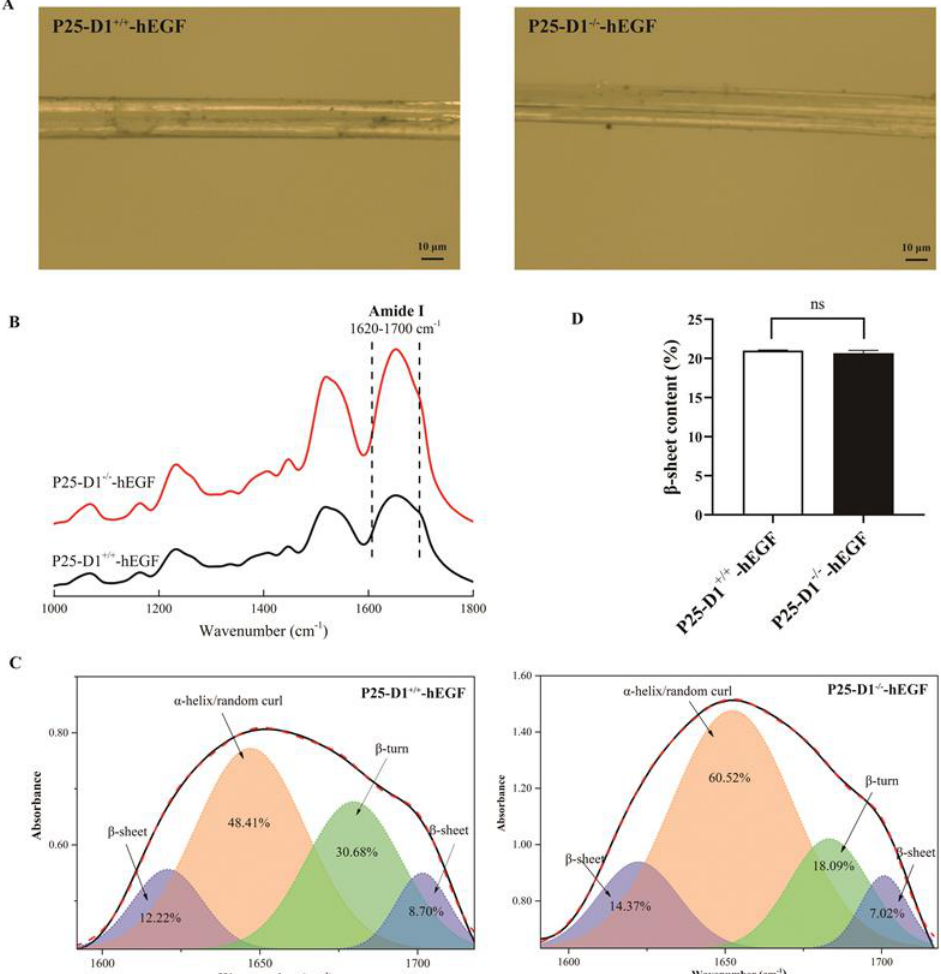
Figure 7. Characteristics of the P25-D1 +/+ -hEGF and P25-D1 − / − -hEGF cocoon silks. ( A ) Photos on the surfaces of the silk fibers of P25-D1 +/+ -hEGF and P25-D1 − / − -hEGF. ( B ) Fourier-transform infrared spectroscopy (FTIR) spectrum from 1000–1800 cm − 1 of the P25-D1 +/+ -hEGF and P25-D1 − / − -hEGF cocoon silks. ( C ) Deconvolution results of amide I bands from the FTIR spectra of the P25-D1 +/+ -hEGF and P25-D1 − / − -hEGF cocoon silks. The number in each peak represents the content of different conformations. ( D ) β -sheet contents of the P25-D1 +/+ -hEGF and P25-D1 − / − -hEGF cocoon silks. The scale bars represent 10 µ